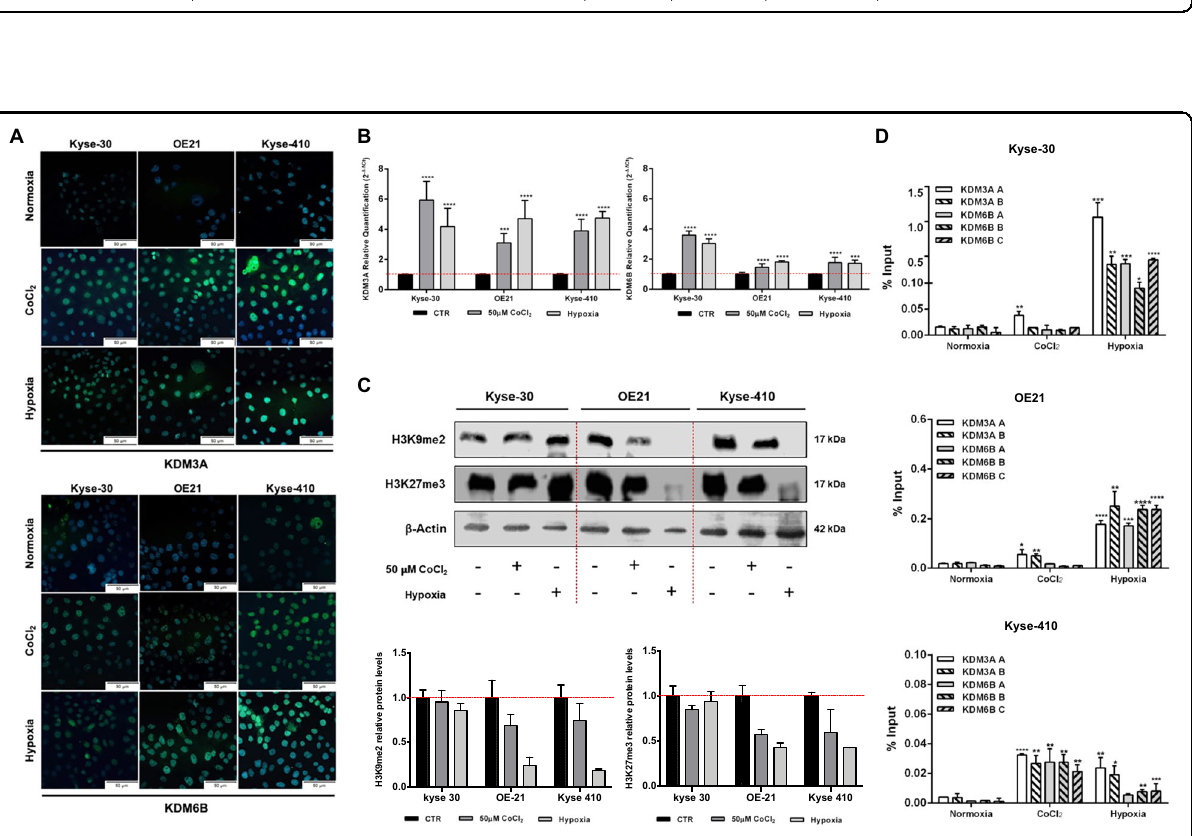
Fig. 1 Effect of hypoxia on RT response, DNA damage, cell migration, and apoptosis. a Cell surviving fraction in three ESCC cell lines irradiated with [0 – 8] Gy range concentration under normoxia, 50 µM CoCl 2 and hypoxia through SHMT model analysis. Results are presented as mean±SD of at least 3 independent experiments. b DNA damage of 2 Gy irradiated ESCC cells between 0 and 24h, under normoxia, 50 µM CoCl 2 and hypoxia by comet assay. The results are the mean of at least 50 comets per condition. All values of DNA fragmentation (tail moment) were normalized to control (0Gy). Further, hypoxic conditions (50µM CoCl 2 or 0.5 – 1% O 2 ) were compared to normoxia. c Representative pictures of nuclear γ -H2AX staining of 2 Gy irradiated ESCC cells under normoxia, 50 µM CoCl 2 and hypoxia conditions. All pictures were taken from Olympus IX51 microscope at ×400 magni fi cation (scale bar 20 μ m). IF quanti fi cation was done using ImageJ software (version 1.6.1, from National Institutes of Health) and represented as a fold change between 2 Gy irradiated cells and non-irradiated control. IF, fl uorescence intensity. d ESCC cell apoptosis under normoxia, 50 µM CoCl 2 and hypoxia conditions with 2 Gy of IR. Results are presented as mean±SD of at least three independent experiments. e ESCC cell migration through wound-healing assay, after 24 h of 2 Gy treatment normalized 0 h. Results are the mean±SD of at least three independent experiments; Irradiated cells are compared to non-irradiated cells in each condition. * p < 0.05; ** p < 0.01; *** p < 0.001; **** p < 0.0001.